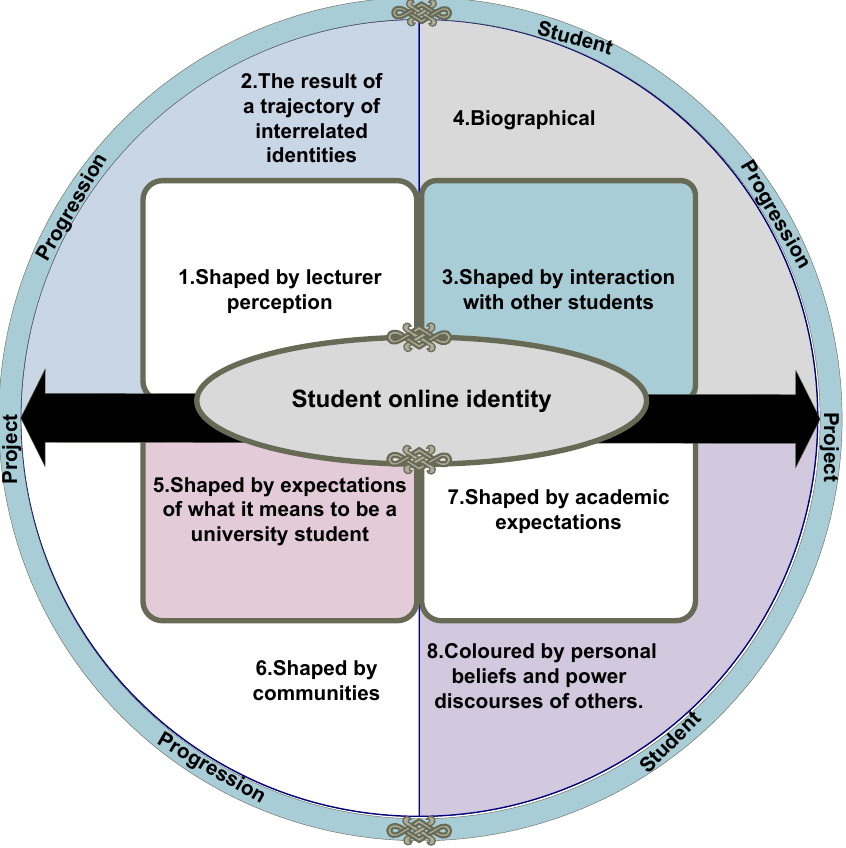
Figure 1 . Factors shaping student identities adapted from Factors Shaping Online Identi - ties (Baxter